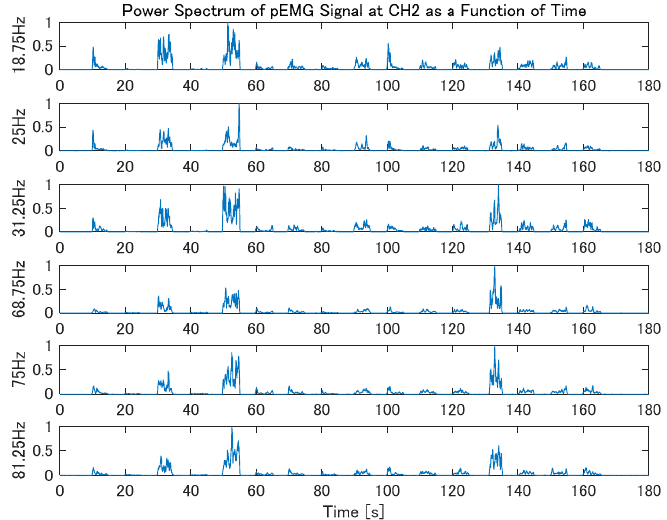
Figure 6. An example of PSDs prior to log transform of 17 motions shown as a function of time. The PSDs are derived from pEMG signals on channel 2. In order from the top, PSDs at 18.75 Hz, 25 Hz, 31.25 Hz, 68.75 Hz, 75 Hz, 81.25 Hz. Note that the PSDs are normalized for better visualization.